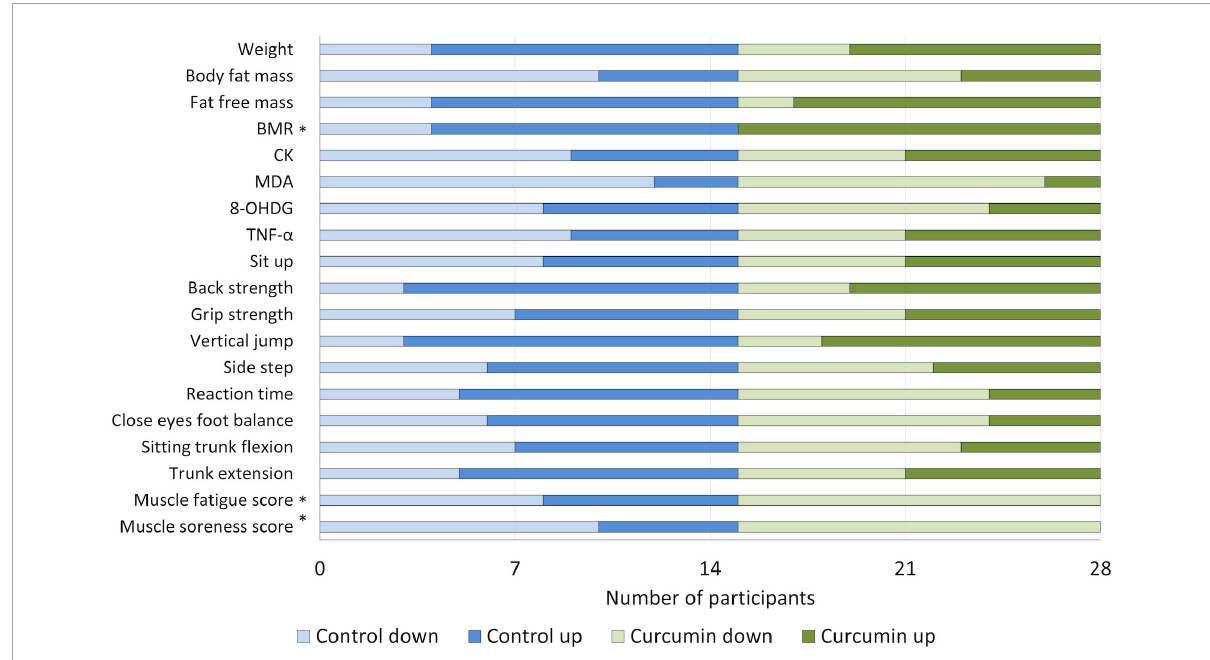
FIGURE2 Comparison of change trends of parameters between the two groups. Asterisk means statistically significant difference between the control and curcumin groups (Chi-square test: BMR, p = 0.044; muscle fatigue score, p = 0.004; muscle soreness score, p = 0.022). 8-OHdG, 8-hydroxy-2 deoxyguanosine; BMR, basic metabolic rate; CK, creatinine kinase; MDA, malondialdehyde; TNF- α , tumor necrosis factor- α